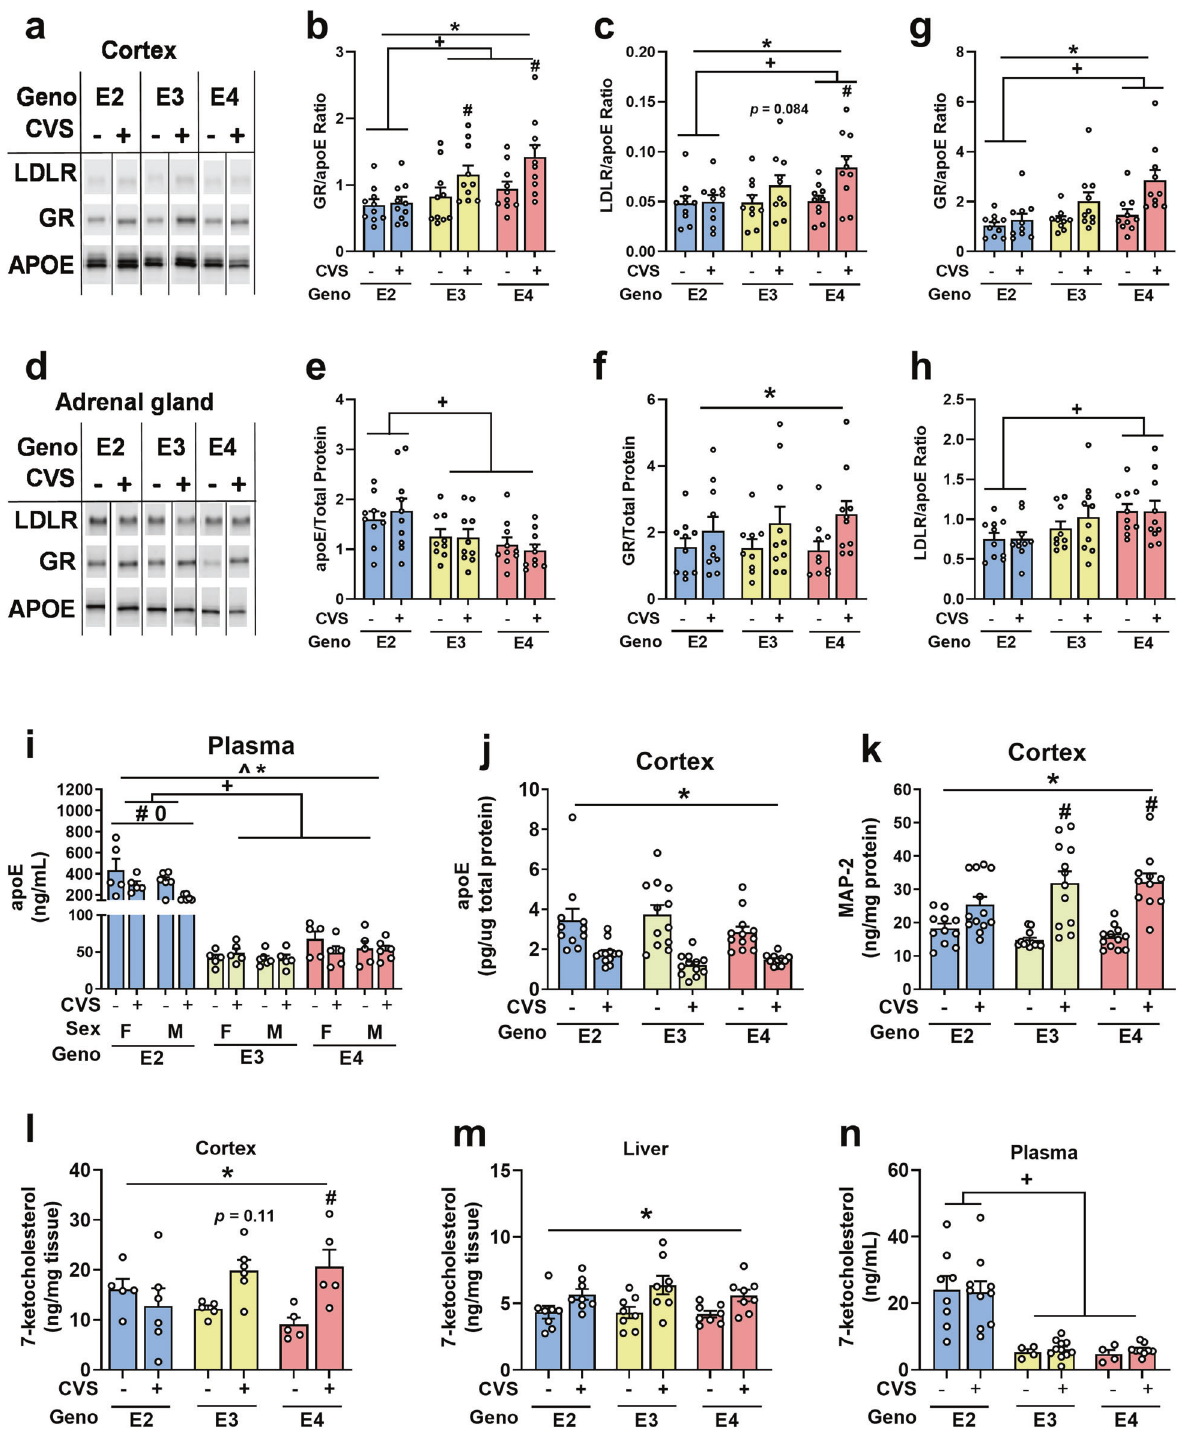
Fig. 4 Protein and lipid measurements in tissue and plasma. a Example cortex Western blot. b E2 mice had the lowest GR/APOE ratio ( + p < 0.05) and E3 and E4 CVS-exposed mice showed larger ratios compared to controls (# p < 0.05). c LDLR/apoE ratios had similar differences to the GR/apoE ratios ( + p < 0.05, # p < 0.05). d Example adrenal gland Western blot. e E2 mice had the highest apoE levels in adr e nal glands ( + p < 0.05). f GR in the adrenal gland was higher in CVS-exposed mice (* p < 0.05). g GR/apoE ratios were lowest in E2 mice ( + p < 0.05). CVS-exposure resulted in higher GR/apoE ratio compared to controls (* p < 0.05). h E2 mice had the lowest LDLR/apoE ratios ( + p < 0.05). i Plasma levels of apoE were hig h est in E2 mice ( + p < 0.05). Furthermore, E2 mice exposed to CVS had lower apoE levels compared to controls (* p < 0.05). Female E2 mice had more plasma apoE than male E2 mice ( 0 p < 0.05). j In cortical tissue, CVS exposure led to lower apoE levels (* p < 0.05). k Meanwhile, MAP-2 levels in the cortex were higher in mice exposed to CVS (* p < 0.05). l Female cortical tissue showed a genotype x group interaction in which only E4 mice exposed to CVS showed higher levels of 7-ketocholesterol compared to controls (# p < 0.05). m CVS exposure was associated with higher 7-ketocholesterol levels (* p < 0.05) regardless of genotype or sex (shown collapsed). n Plasma levels were highest in E2 mice ( + p < 0.05, shown with sexes collapsed). Symbols: + refers to pairwise comparison of genotype effect, * refers to CVS effect, ^ refers to sex effect, # refers to genotype x CVS interaction, 0 refers to sex x genotype interaction. Translational Psychiatry (2022)